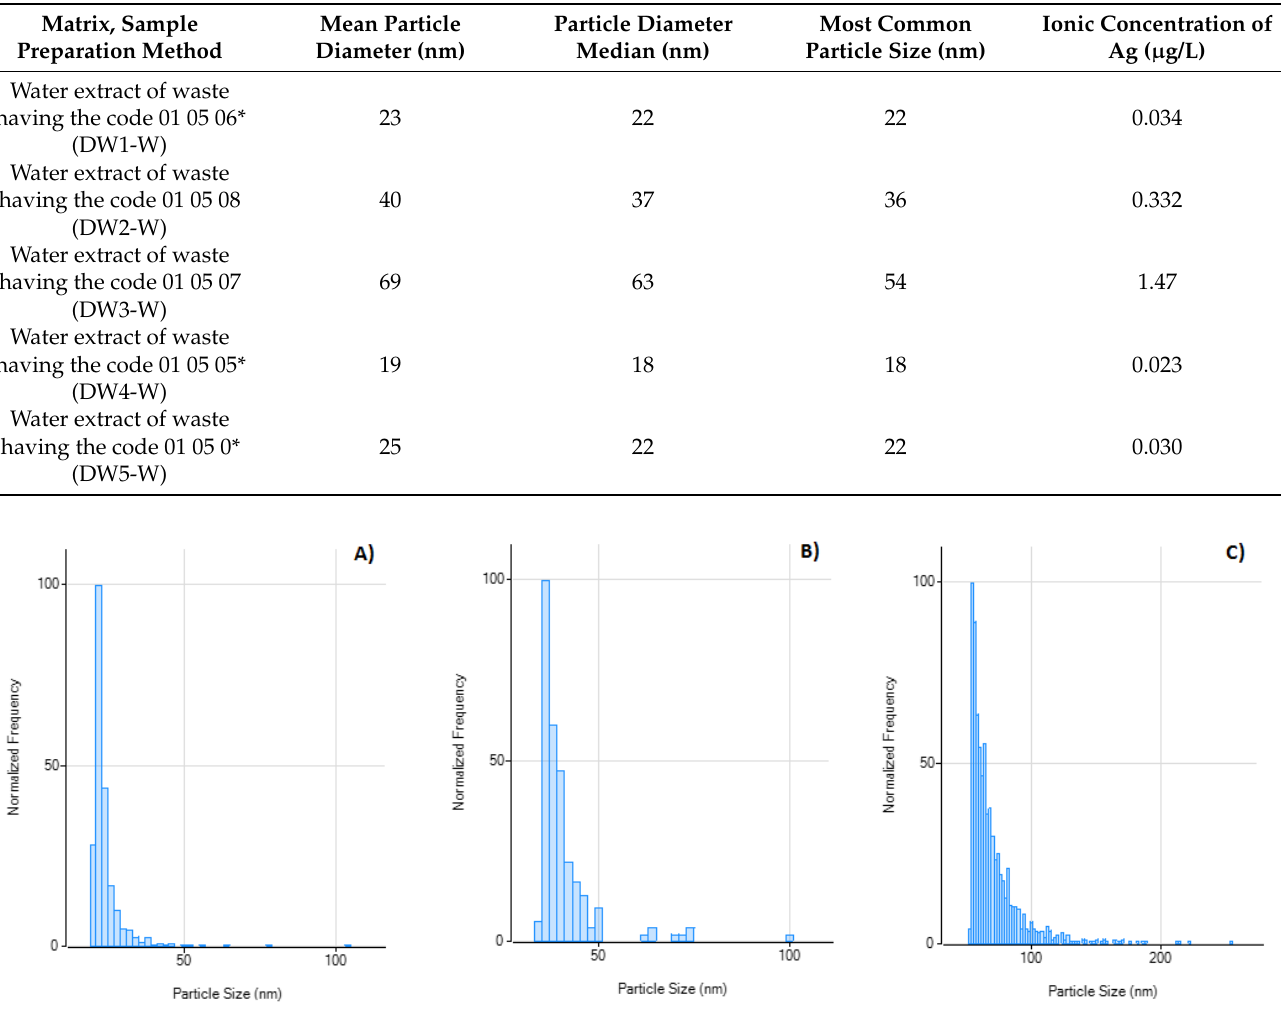
Figure 5. Silver particle size distribution recorded by the spICP-MS technique for a sample of water extract of drilling waste without added AgNPs designated as DW1-W ( A ), DW2-W ( B ), and DW3-W ( C ). Table 4. Verification of the effect of centrifugation velocity for a centrifugation time of 15 min on nanoparticle separation efficiency for water extract samples DW(1–5)-W of drilling waste enriched with AgNPs (60 nm). Matrix Size of AgNPs Introduced into the Matrix